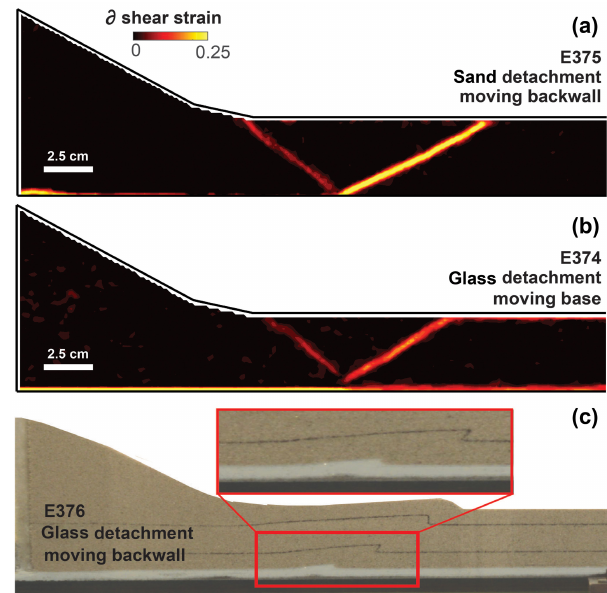
Figure 6. Shear strain of incremental displacement fields of exper- iments excluding (a) and including (b) glass bead layer following faulting. The shear strain fields reveal that the inclusion of a glass bead layer suppresses slip on the thrusts. (c) Photo of side of experi- ment E376 following faulting. The entrainment of glass beads along the forethrust promoted slip on the forethrust and suppressed the lo- calization of the backthrust, perhaps by producing a smoother tran- sition zone near the base of the forethrust. This suppression of slip on the thrusts reduced the change in δW fric produced by thrust fault- ing in experiment E374 (glass detachment) relative to that change in experiment E375 (sand